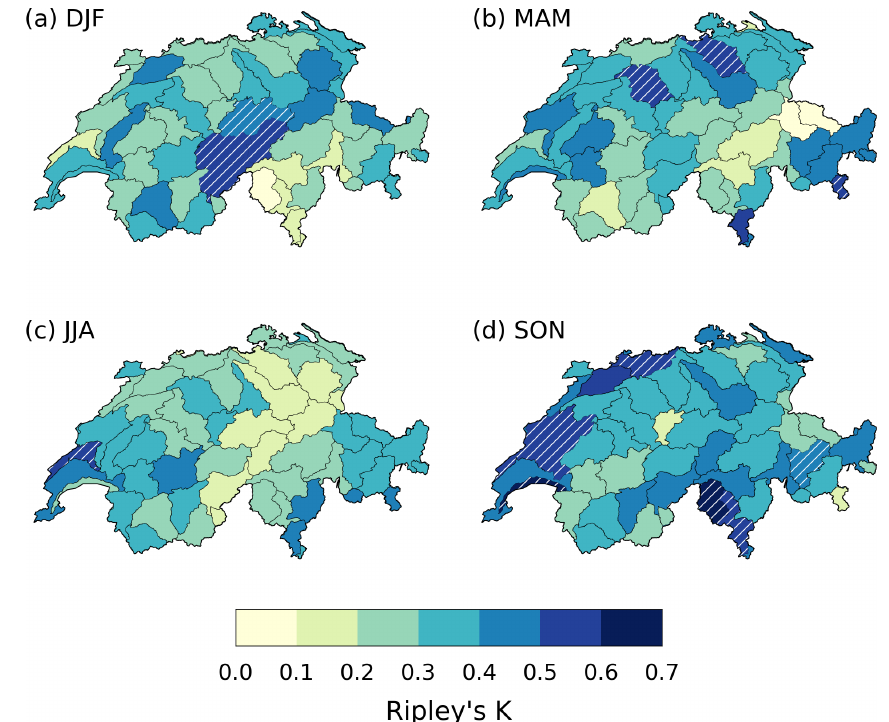
Figure 4. Value of Ripley’s K in the RhiresD dataset for a 20d window (shaded) and clustering significance for a time window of 15–25d (white hatching) in (a) DJF, (b) MAM, (c) JJA and (d)